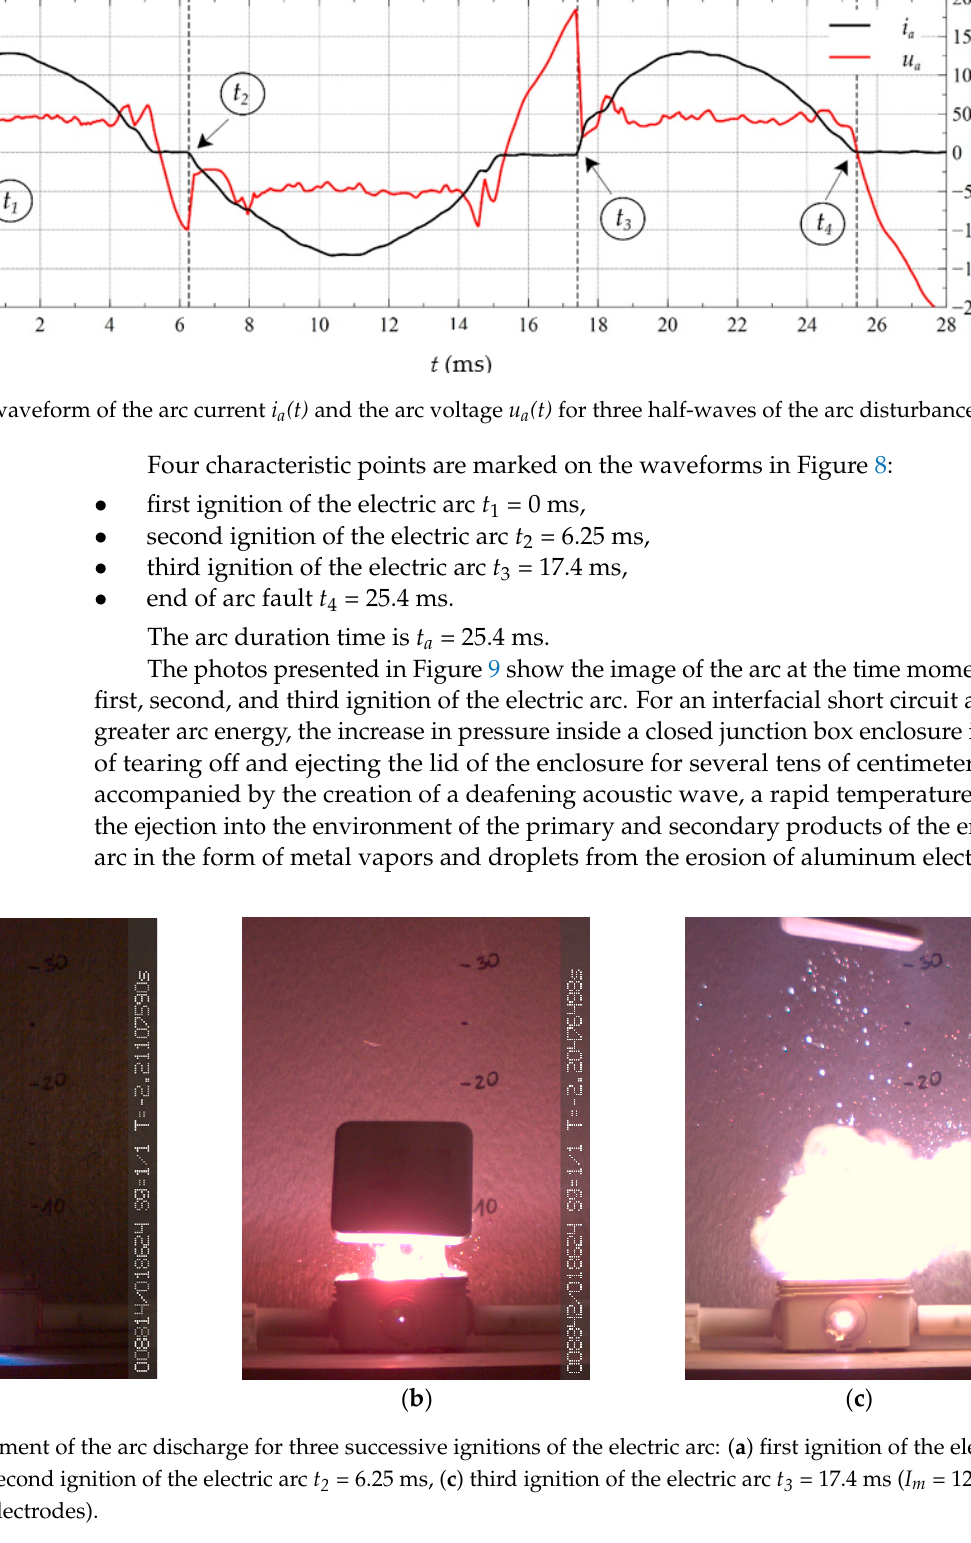
Figure 9. Development of the arc discharge for three successive ignitions of the electric arc: ( a ) first ignition of the electric arc t 1 = 0 ms, ( b ) second ignition of the electric arc t 2 = 6.25 ms, ( c ) third ignition of the electric arc t 3 = 17.4 ms ( I m = 1250 A, U = 400 V, Al-Al electrodes).